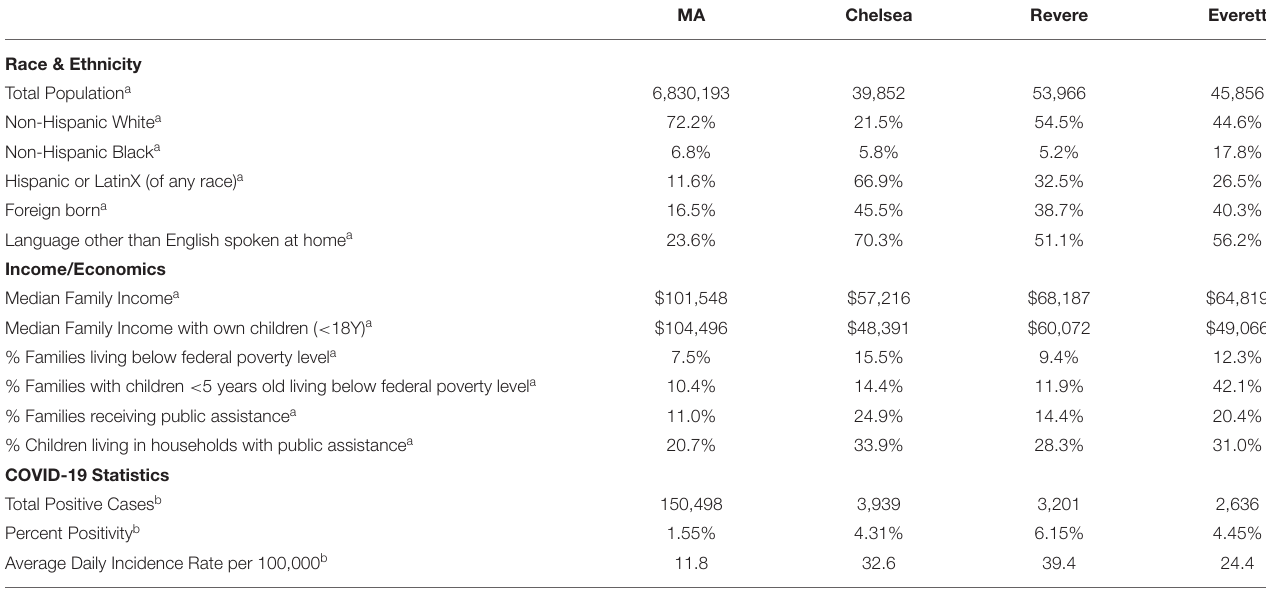
TABLE 1 | Characteristics of community populations served by HUGS/Abrazos program.